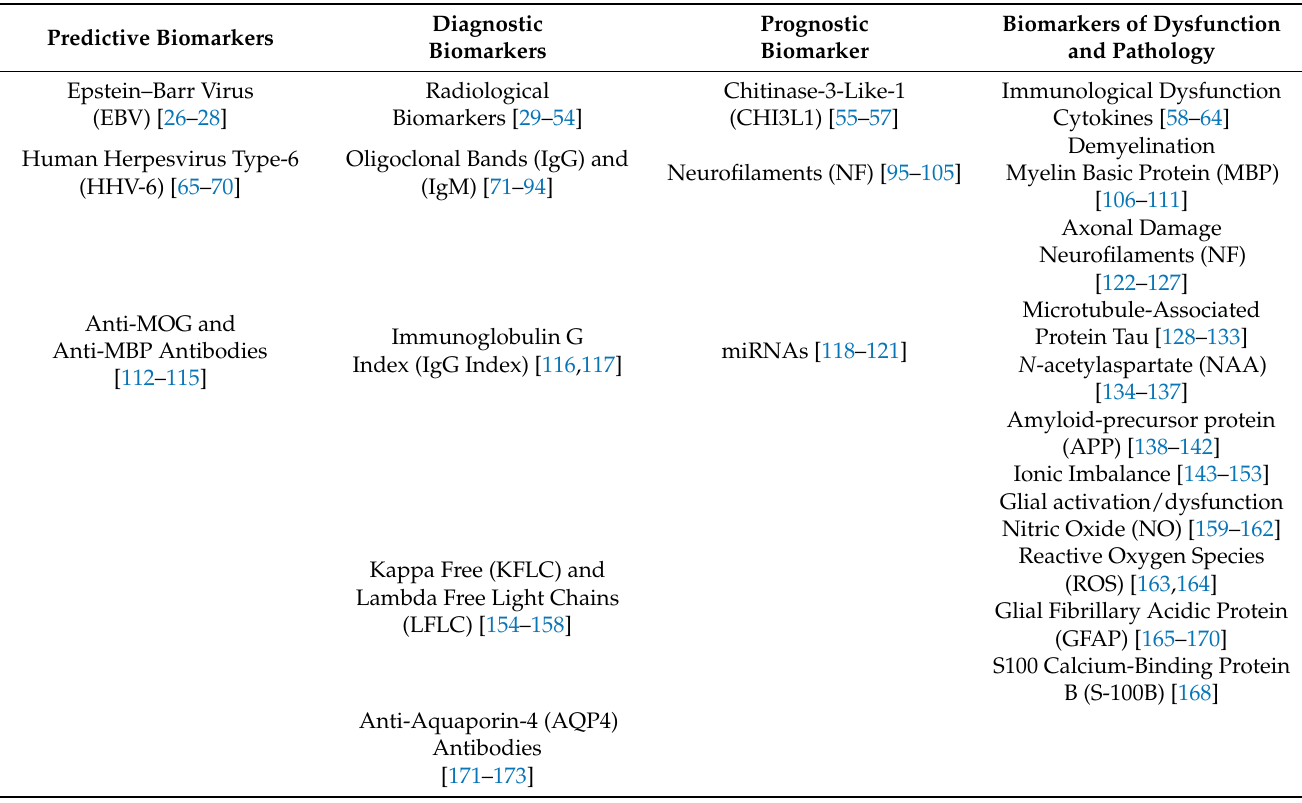
Table 2. Radiological biomarkers and biomarkers identified in CSF and serum samples and their standard clinical use in MS. Diagnostic Predictive Biomarkers